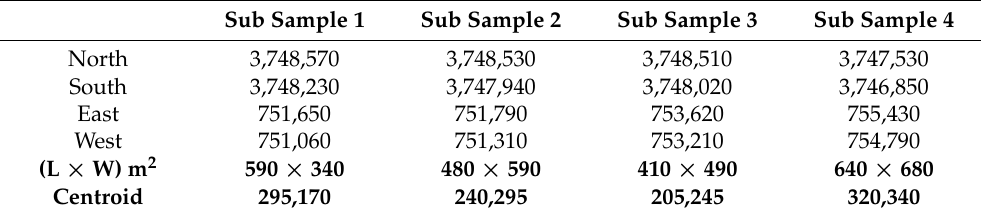
Table 2. Sub sample coordinates in WGS 84/UTM zone 42N system.